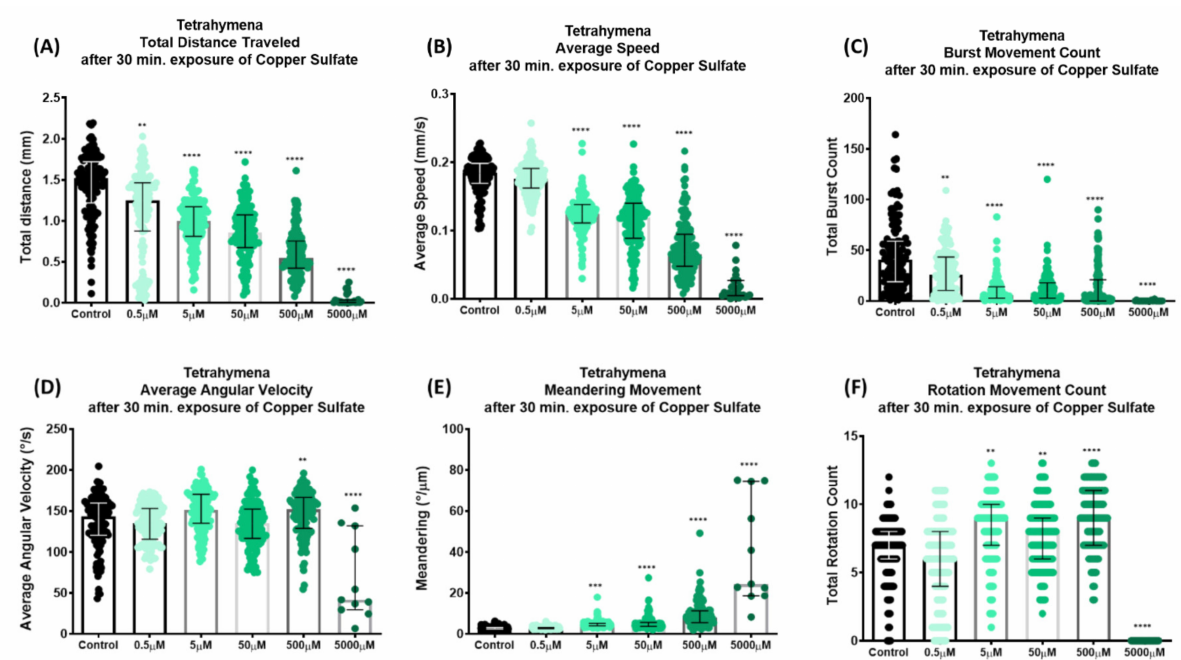
Figure 5. Comparison of T. thermophila locomotor activity after 30 min. exposure of copper sulfate. Six locomotor endpoints of ( A ) total distance traveled, ( B ) average speed, ( C ) burst, ( D ) average angular velocity, ( E ) meandering, and ( F ) rotation movement were calculated based on the 10 s video recording. The data were statistically analyzed by Kruskal–Wallis test ( n = 129 for each group, except for 5000 µ M n = 26; ** p value < 0.01; *** p value < 0.001; **** p value < 0.0001). Median and interquartile range are used to express the data. Cumulative trajectory paths are presented in Figure